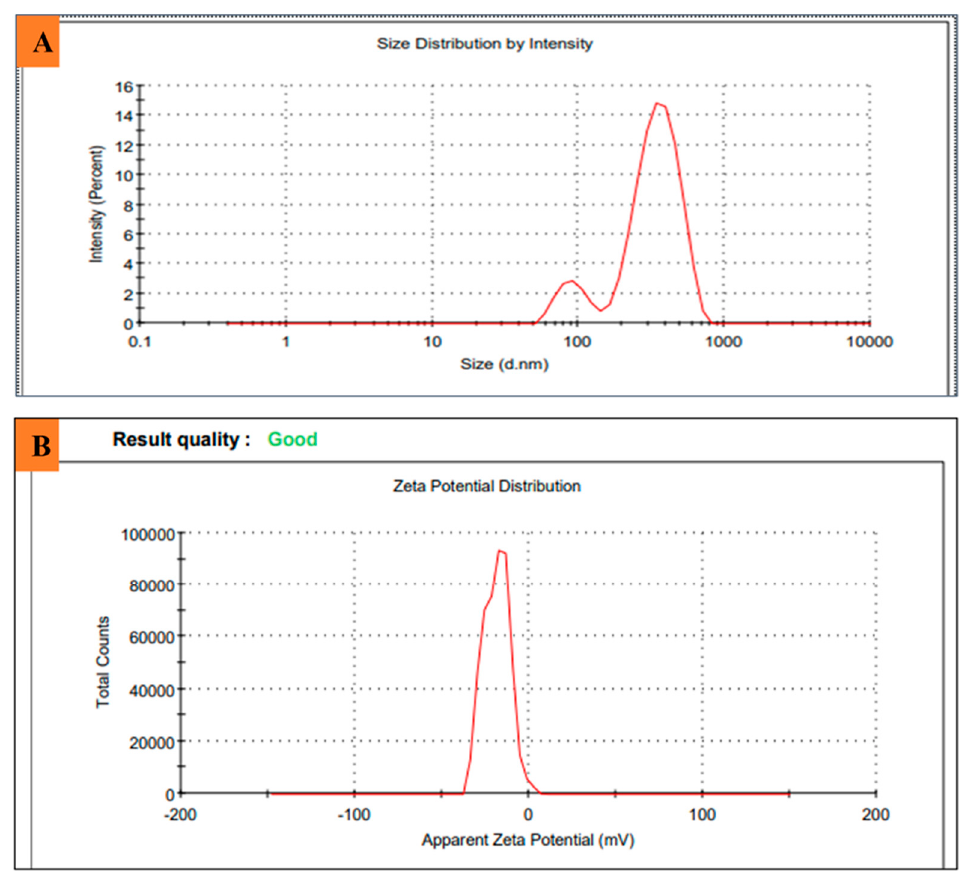
Figure 5. ( A ) Particle size distribution of P . alsinaefolia Ag 2 ONPs; ( B ) zeta potential measurement of P . alsinaefolia Ag 2 ONPs.